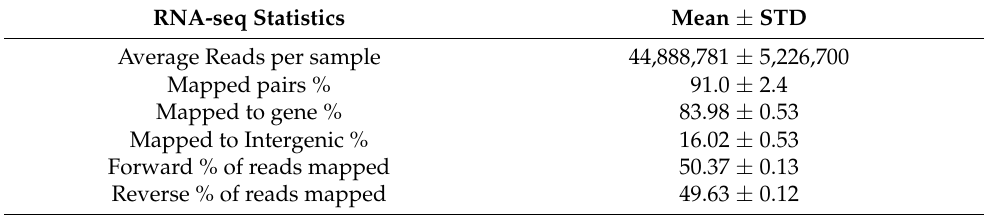
Table 1. Statistics of RNA sequencing. RNA-seq Statistics Average Reads per